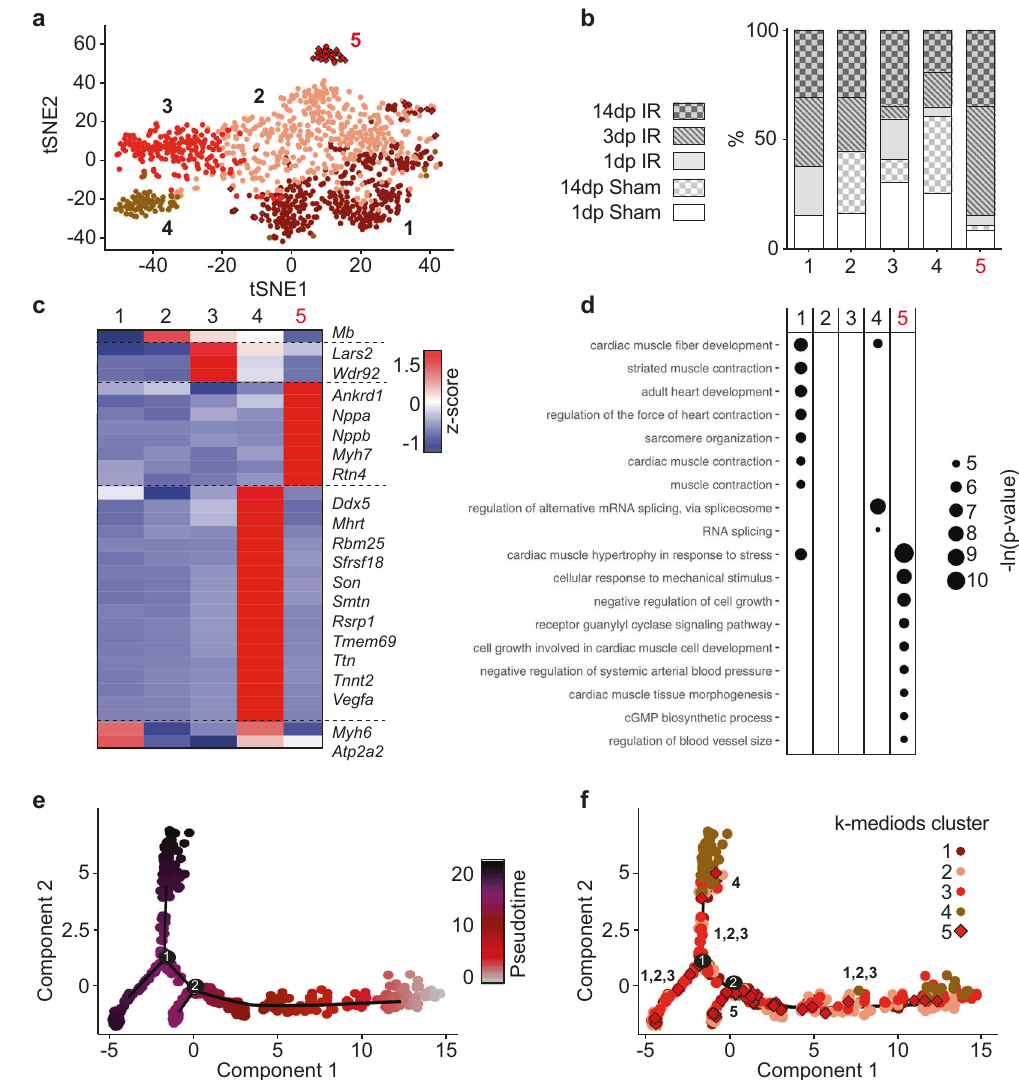
Fig. 2 Single-cell sequencing indicates cardiomyocyte heterogeneity. a tSNE plot indicating transcriptomic similarities across cardiomyocytes obtained from all conditions. Different colors, symbols and numbers highlight the clusters as determined by k-medoids clustering of 1 − Pearson ’ s correlation coef fi cient. b Bar graph showing the proportion of cardiomyocytes originating from the different condition per cluster. c Heatmap showing expression of all genes signi fi cantly enriched in at least one cluster. Examples of genes enriched per cluster are depicted on the right side of the heatmap. d Bubble plot of top GO terms in gene ontology analysis on genes signi fi cantly enriched within the cluster. b – d Numbers highlighted in red depict a cluster that mainly contains 3 dp IR and 14 dp IR cardiomyocytes (cluster 5). e , f Cell trajectory analysis of cardiomyocytes, showing pseudotime on a color-coded scale ( e ) or highlighting the k-medoids cluster of each cardiomyocyte in the trajectory plot ( f ). The regions in the branches of the trajectory plot that contain mostly cells from k-medoids clusters 1,2,3 or cluster 4 or cluster 5 are highlighted by